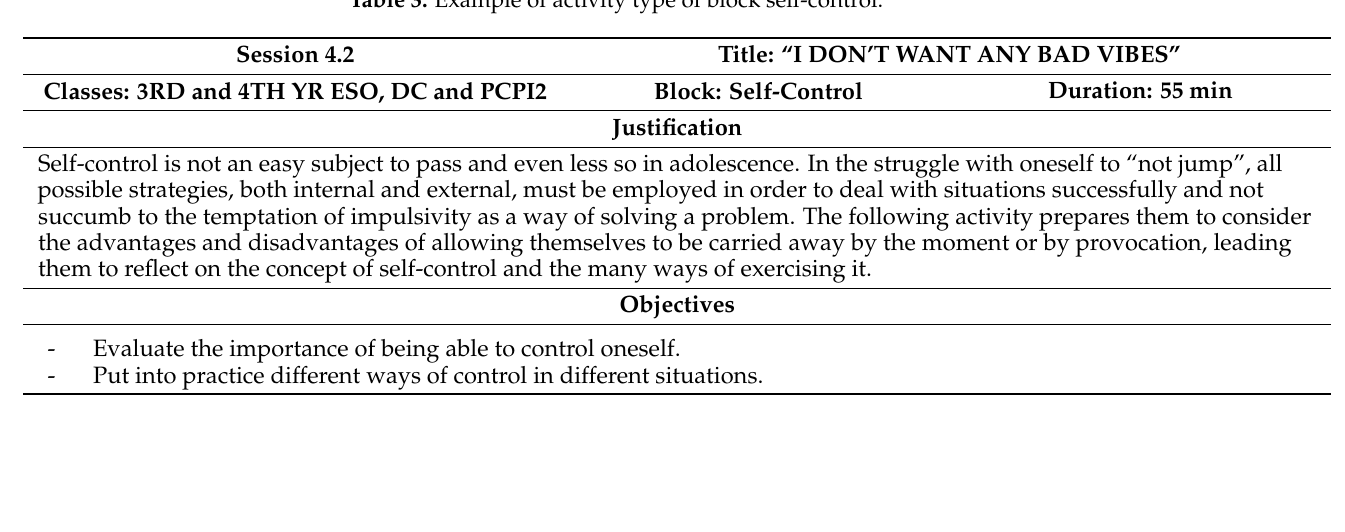
Table 3. Example of activity type of block